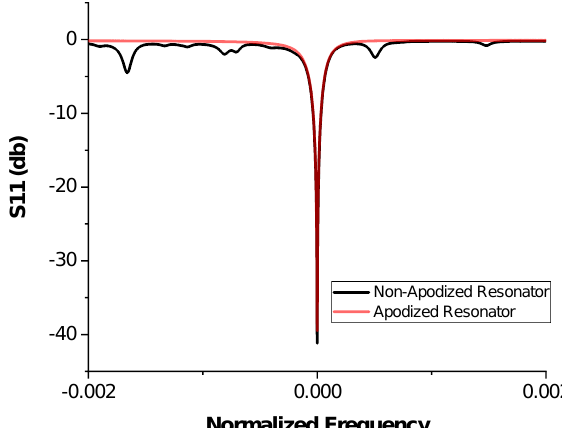
Figure 4. The effect of apodization. S11 responses for apodized and non-apodized resonators.